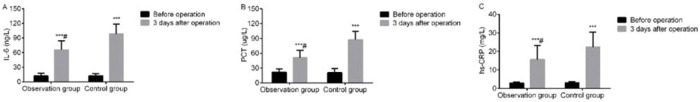
Intergroup comparison of serum inflammatory reactivity. At 3 d after LC, the serum IL-6, PCT, and hs-CRP levels increased in both groups but were lower in OG than in CG (p<0.05) A: IL-6; B: PCT; C: hs-CRP. Note: ***p<0.05 versus preoperative values.